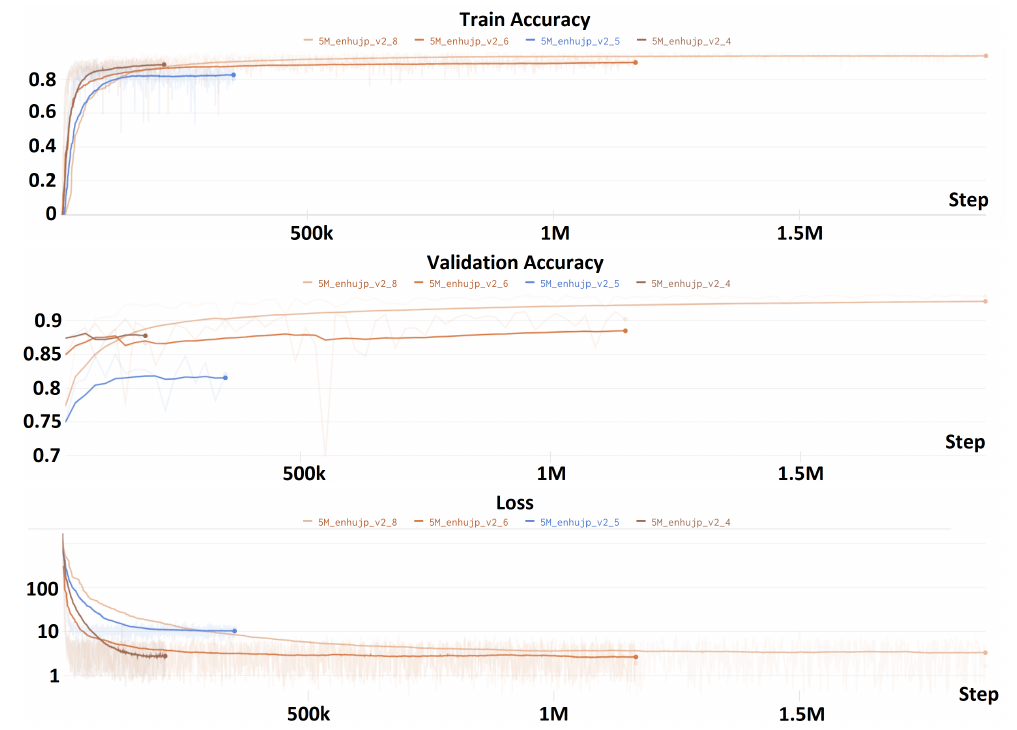
Figure 17. Comparison of experiment 11, 12, 13, and